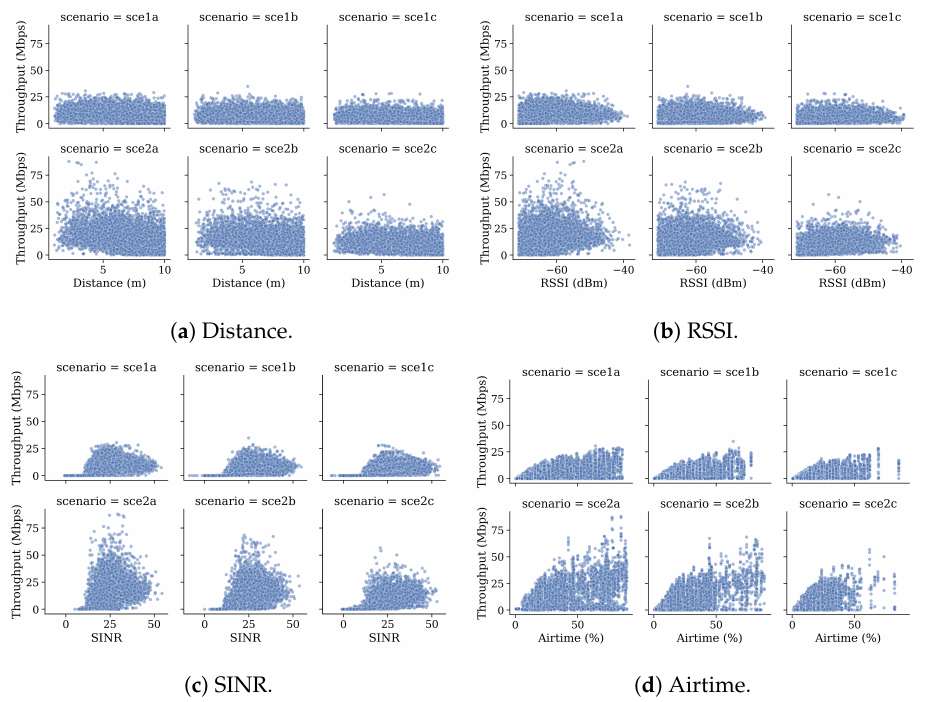
Figure 7. Relationship between throughput and main features per training